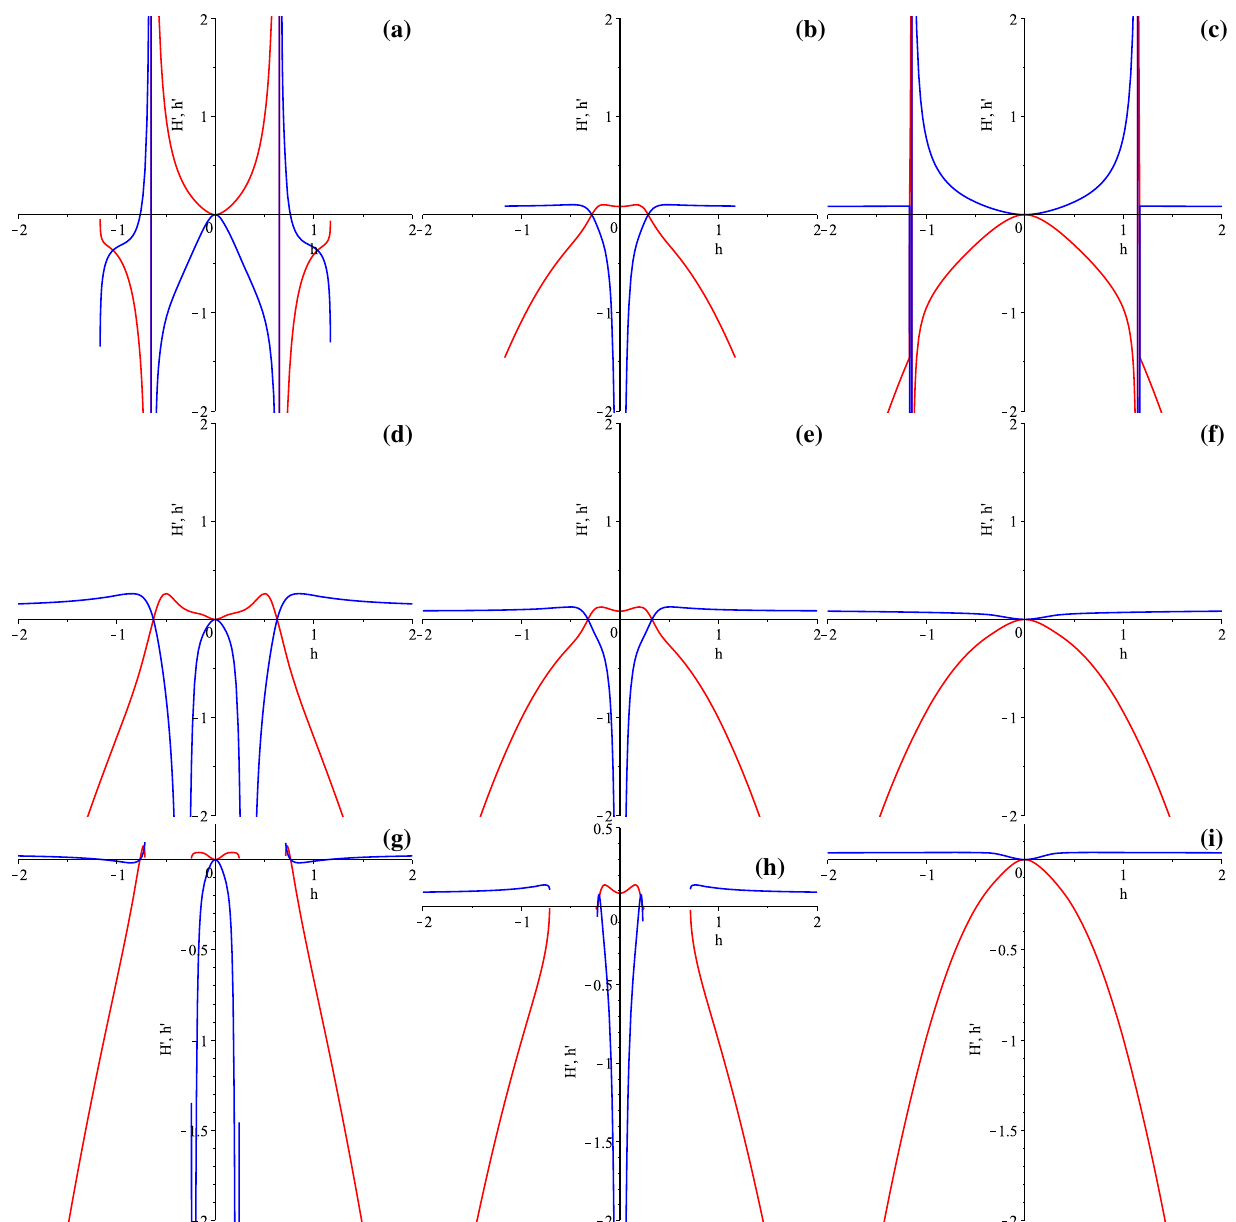
Fig. 2 ˙ H ( h ) and ˙ h ( h ) graphs for vacuum D = 3 case: ˙ h ( h ) in red and branch on f panel; α < 0, β > 0, μ > 3 / 2 on g – i panels: H 1 branch on ˙ H ( h ) in blue; α < 0, β < 0 on a – c panels: H g panel, H 2 branch on h panel and H 3 branch on i panel (see the text 1 branch on a panel, H 2 for more branch on b panel and H 3 branch on c panel; α < 0, β > 0, μ < 3 / 2 on d – f panels: H 1 branch on d panel, H 2 branch on e panel and H 3